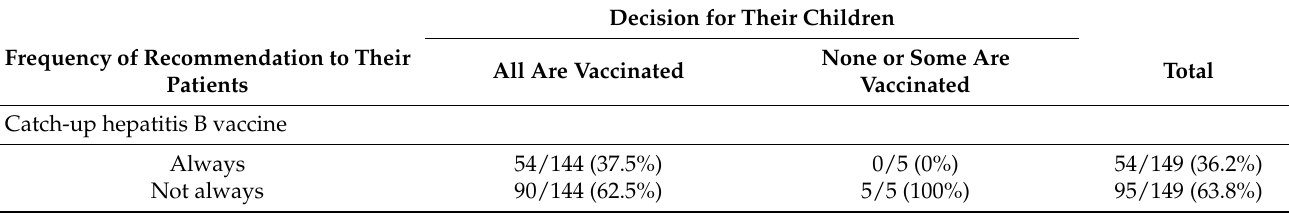
Table 5. Comparison of the typology of general practitioners with moderate to high vaccine hesitancy identified in the present study and the original study by Verger et al.